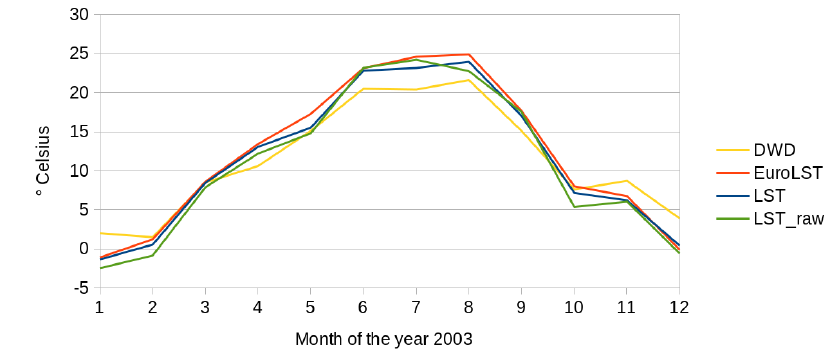
Figure 8. Comparison of monthly averages for 2003 for Bonn, Germany from the new LST reconstruction (LST), the old LST reconstruction (“EuroLST” data, [5]), the original LST values of the MODIS 11A1 products (LST_raw), and air temperature from ground station records from the German Weather Service